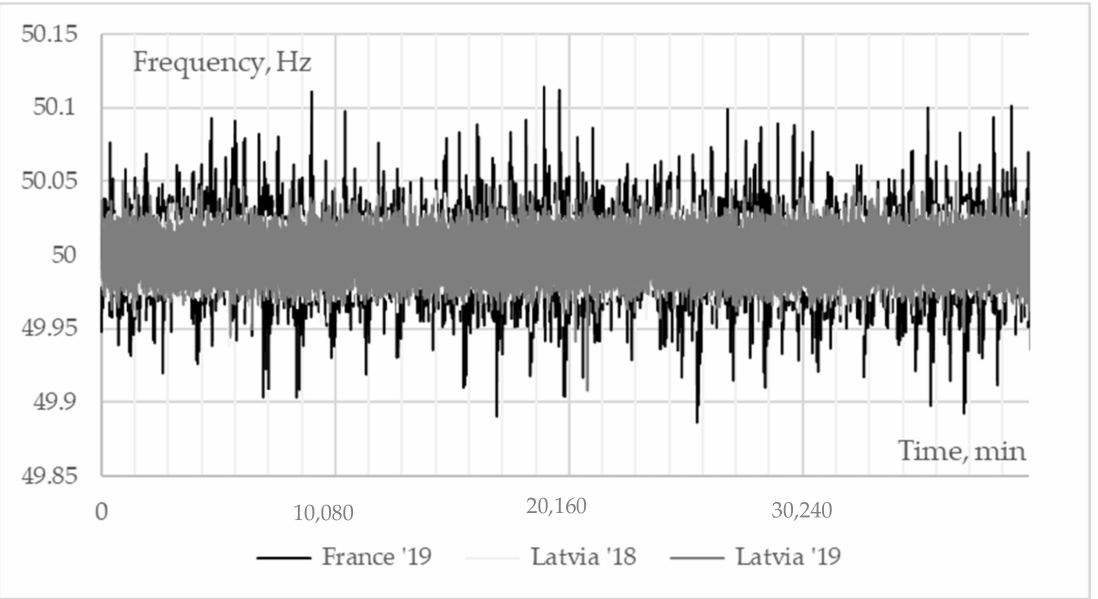
Figure 4. Frequency changes in Latvian and French power systems on monthly (February)